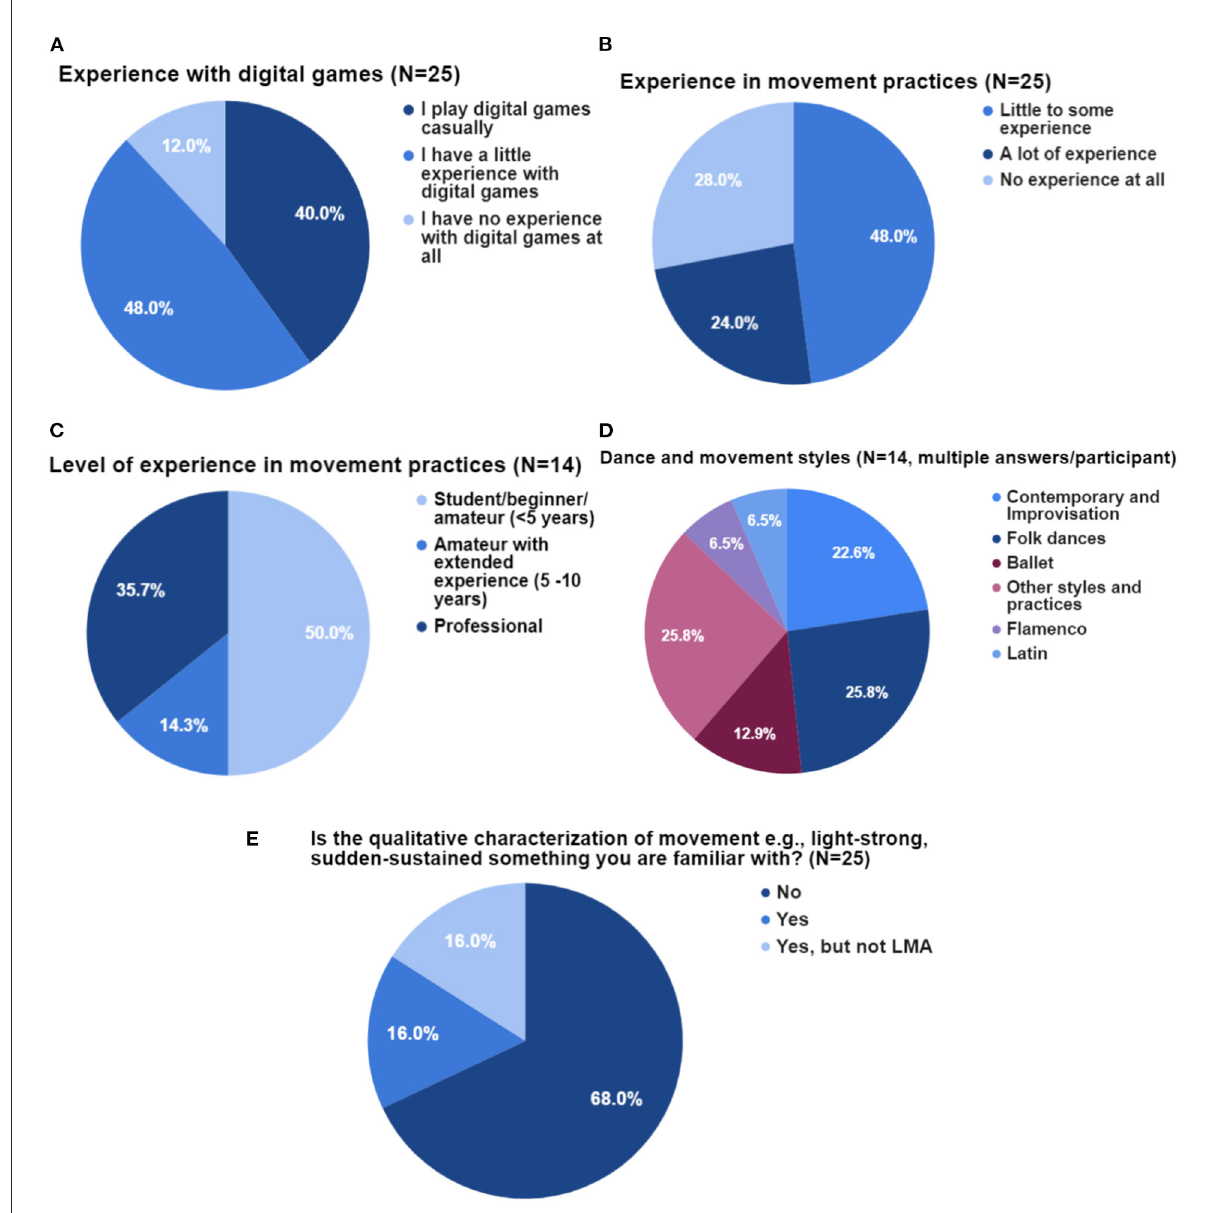
FIGURE8 Participants’ background. Panel (A) shows their experience with digital games, (B) experience with movement practices, (C) level of experience in movement practices, (D) dance and movement styles they are familiar with and (E) the level of familiarity with movement characterization.